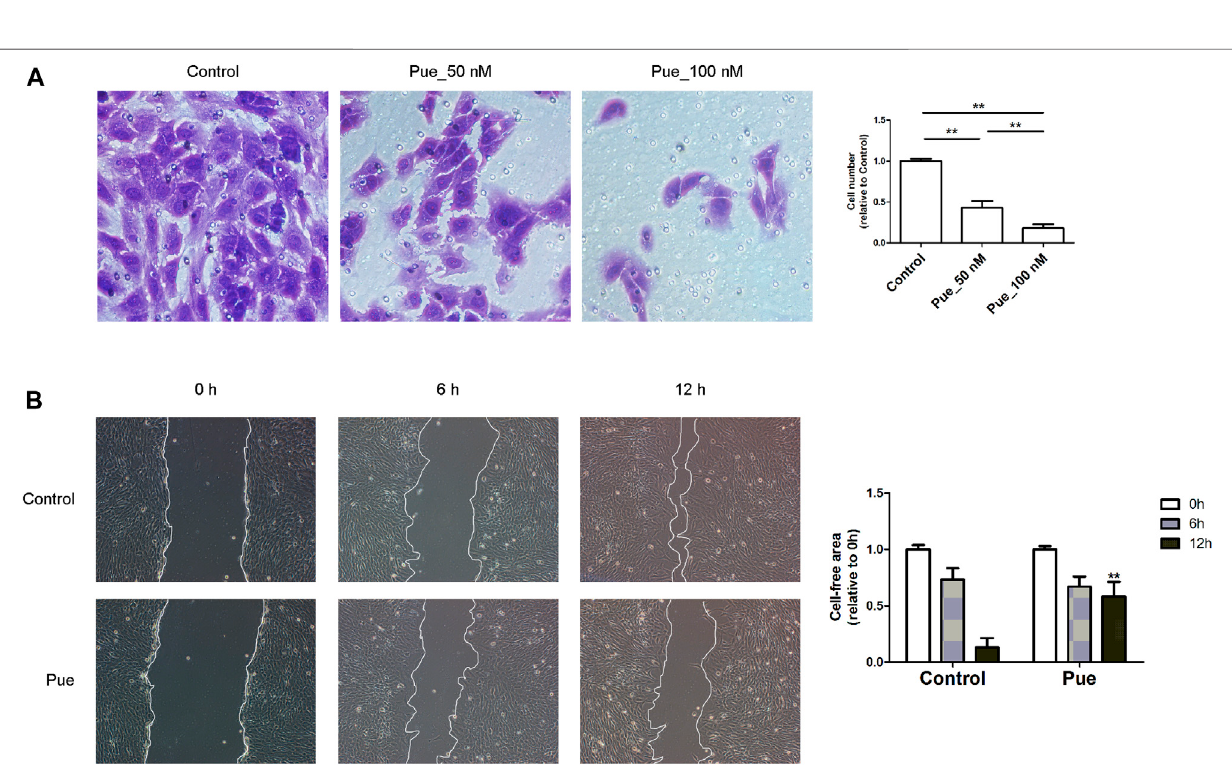
Figure 3B , the velocity of HPSCs migrating into the wound gap